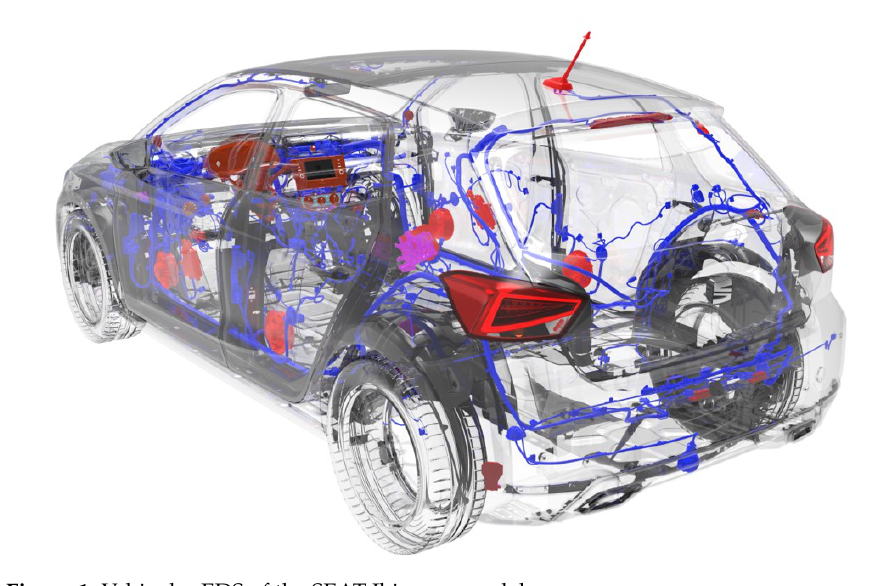
Figure 1. Vehicular EDS of the SEAT Ibiza car